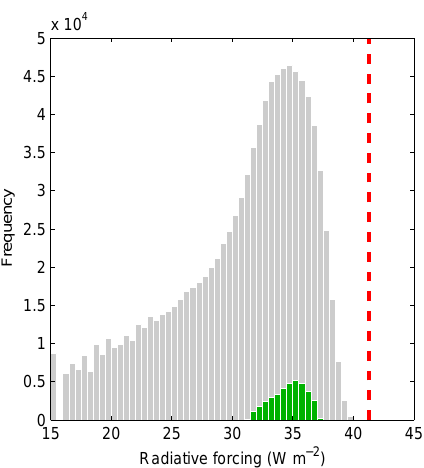
Fig. 4. Histogram of radiative forcings from two subsets of cloud profiles. Cloud sets which give energy balance at the TOA (sub- set 1) in light grey, cloud sets which give energy balance at the TOA and are close to observed longwave and shortwave fluxes at the TOA superimposed darker (green online). Dashed vertical line (red online) shows radiative forcing cloud-free case for